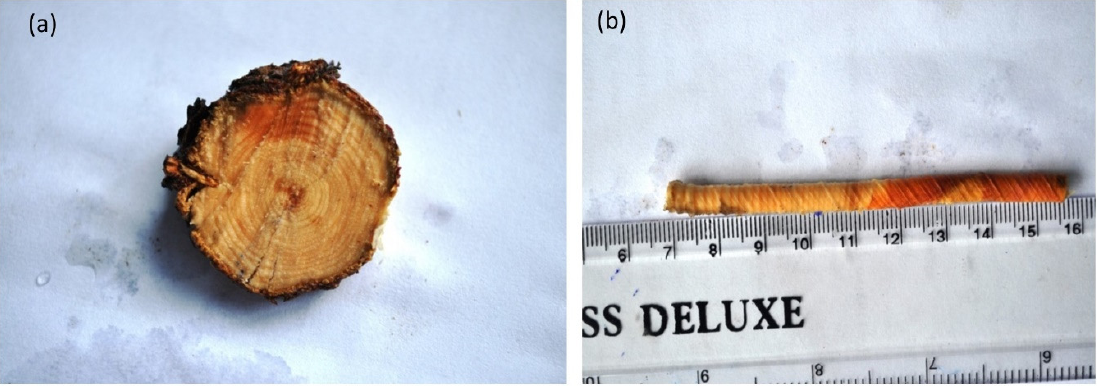
Figure 2. ( a ) Tree cross-section section showing distinct growth rings, ( b ) Wood core sample showing distinct growth rings.